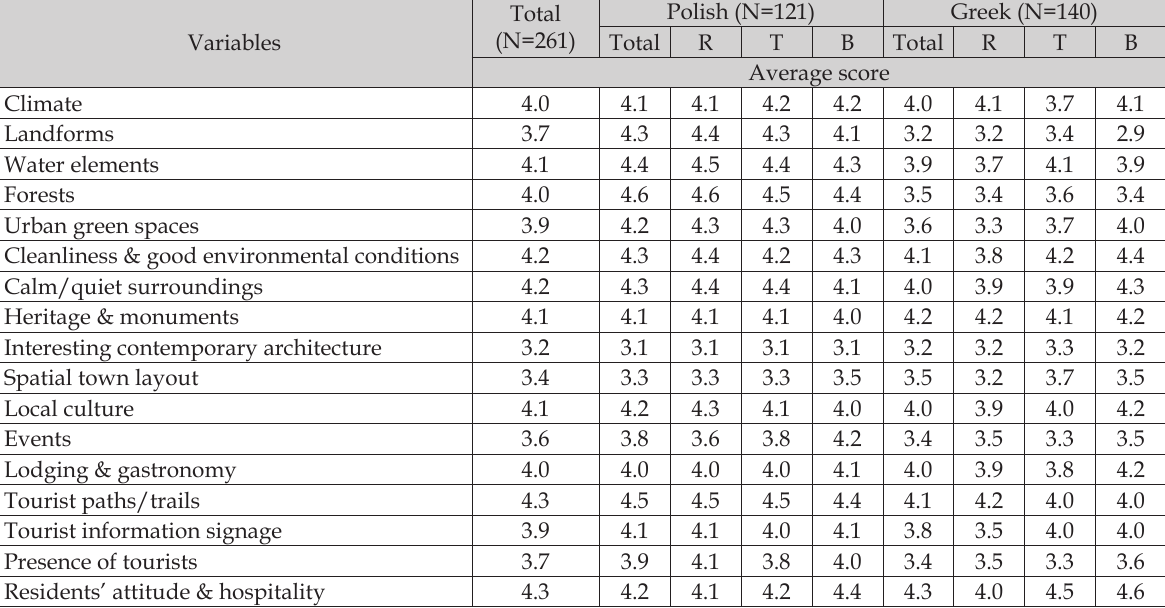
Table 3. Respondents’ assessment of the contribution of selected elements of the landscape to its attractiveness as a tourist landscape (R – residents, T – tourists, B – business